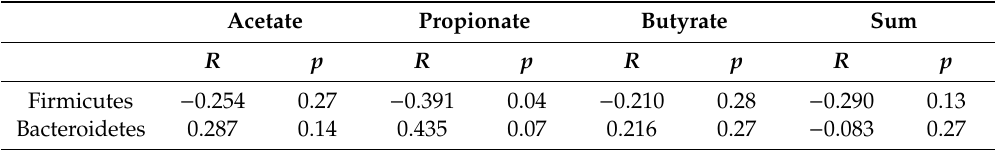
Table 3. Correlation between percent relative abundance of bacteria and SCFA concentration after 2 week spice